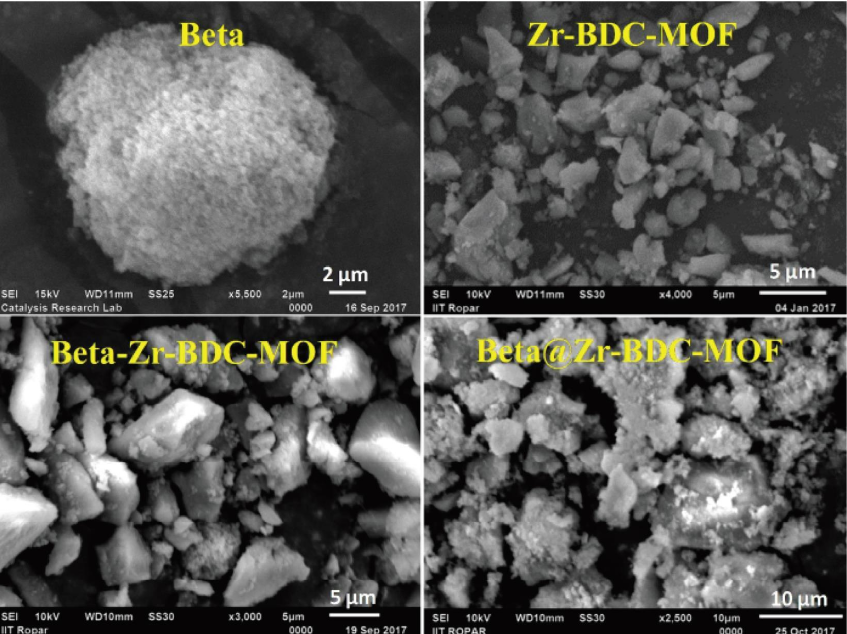
Figure 12: SEM images of parent and Zeolite@Zr-BDC-MOF composite adopted from